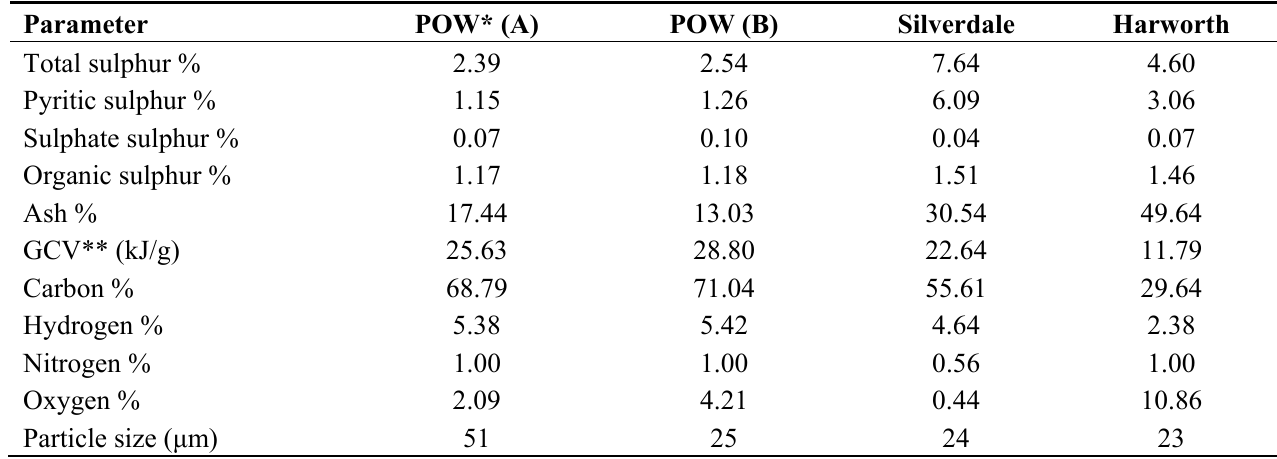
Table 1. Analysis of the untreated